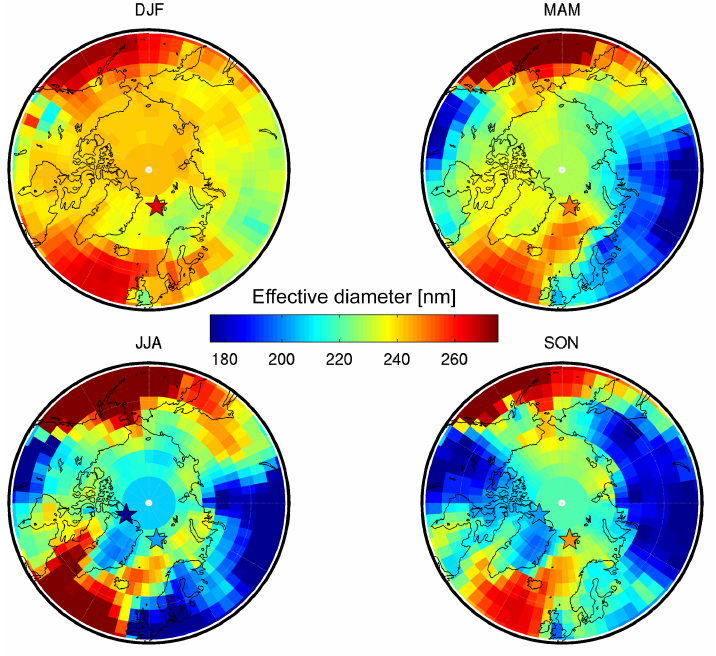
Figure 7. Geographic distribution of the simulated pan-Arctic surface-layer seasonal-mean dry effective diameter (nm) for the NEWSCAV + COAG simulation. The coloured stars indicate the effective diameter from measurements at Alert (SMPS) and Mt. Zeppelin (DMPS).